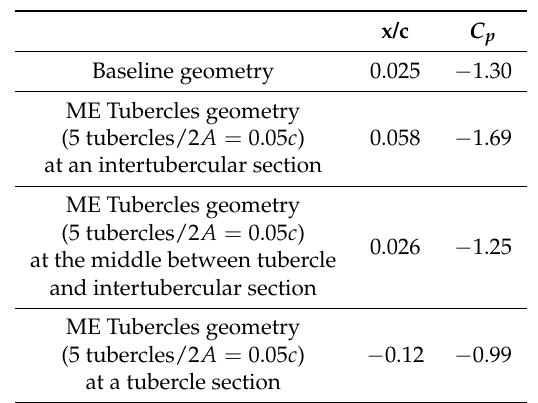
Table 7. Comparison of the peak pressure coefficient on the intrados for both baseline and ME Tubercles (5 tubercles/2 A = 0.05 c ) geometries at different section along the span of the front wing.